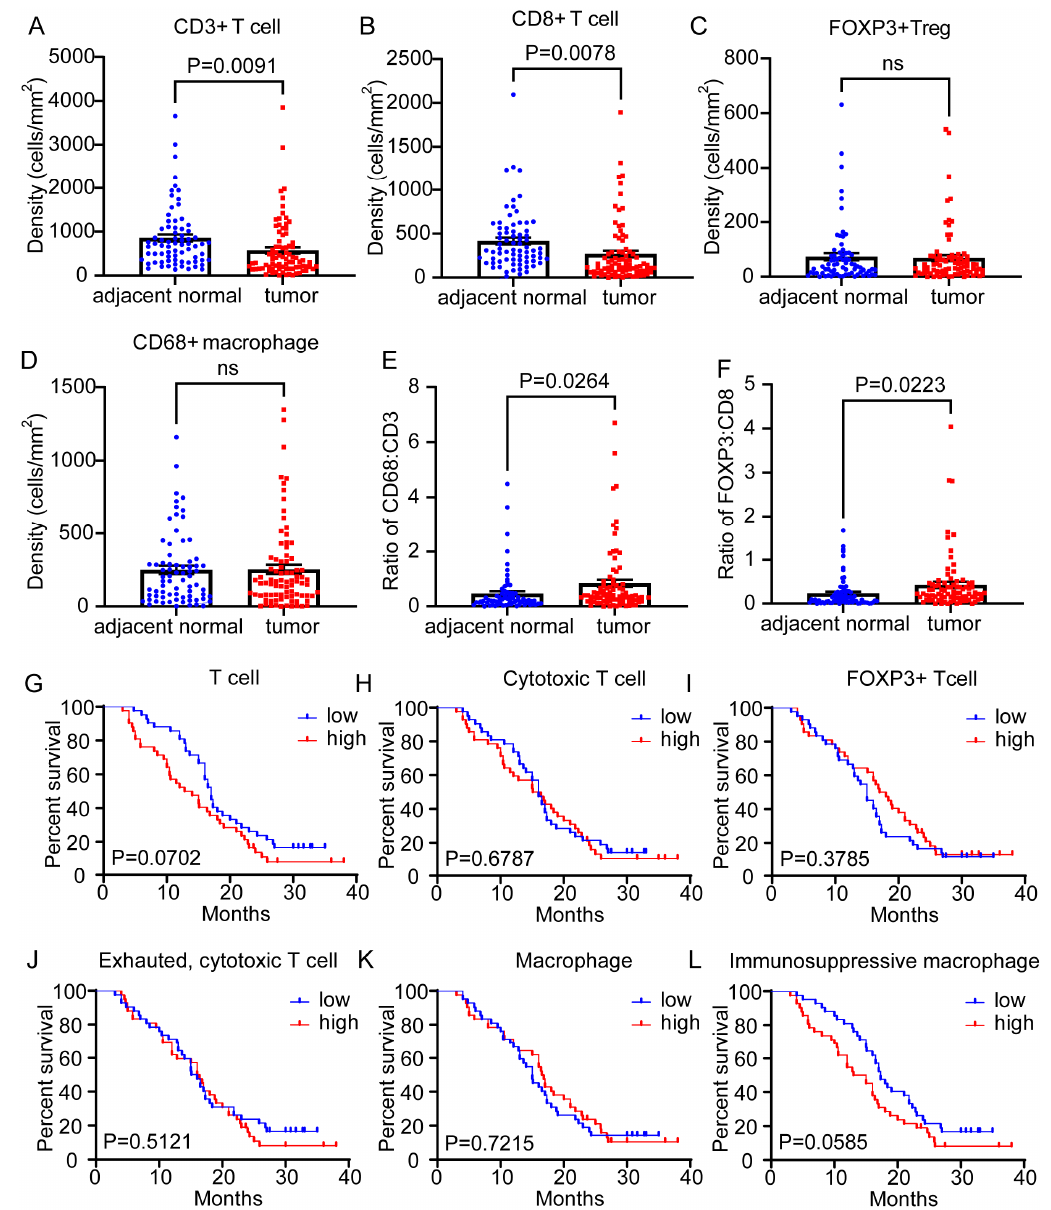
Figure 2. The analyzed phenotypes demonstrated an immunosuppressive microenvironment in PDAC with no prognostic value identified as an independent factor. ( A , B ) Compared with those in the adjacent normal samples, the densities of CD3 + T cells and CD8 + cytotoxic T cells in the tumor samples were significantly reduced ( p < 0.01). ( C , D ) There were no differences in the densities of FOXP3 + Tregs and CD68 + macrophages between the adjacent normal and tumor samples. ( E , F ) Compared with the adjacent normal tissues, the ratio of CD68/CD3 or FOXP3/CD8 in the tumor tissues was significantly increased ( p < 0.05). ( G – L ) Survival data on 84 PDAC patients were collected, including the following: different T cell (CD3 + ) densities; cytotoxic T cell (CD3 + CD8 + ) densities; FOXP3 + T cell (CD3 + FOXP3 + ) densities; exhausted, cytotoxic T cells (CD3 + CD8 + PD-1 + ) densities; macrophage (CD68 + ) densities; immunosuppressive macrophages (CD68 + PD-L1 + ). There were no significant differences in the OS outcomes ( p > 0.05) of the patients with high- or low-cell populations among the analyzed phenotypes. The median was used as a cutoff value to classify the patients into high- and low-expression groups. The error bars represent SEMs. The statistical analyses between the adjacent normal and tumor samples were conducted using Student’s t -tests. A log-rank test was used to determine the significance of the survival